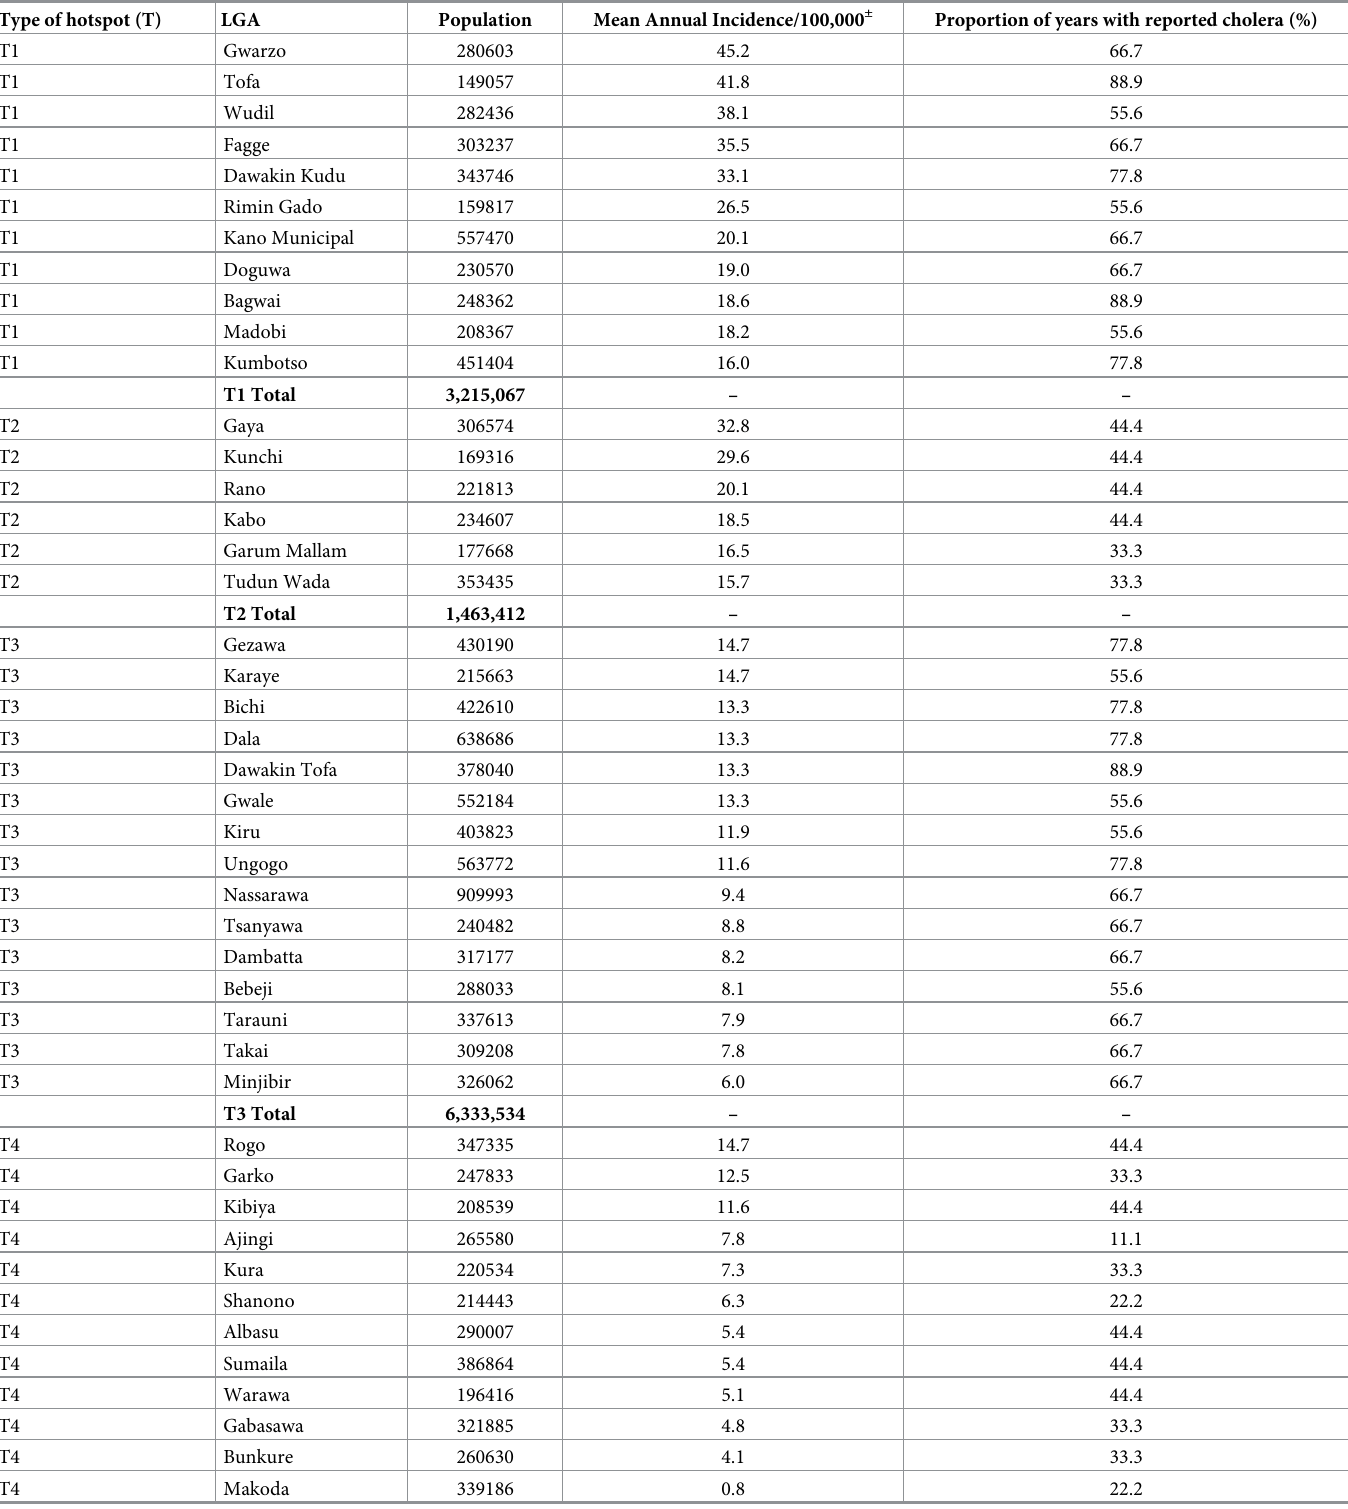
Table 3. LGAs with the type of hotspots based on mean annual incidence rate and proportion of years with reported cholera cases. Type of hotspot